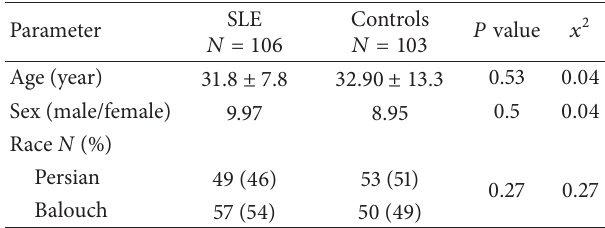
Table 2: Demographic characteristics of SLE patients and controls.